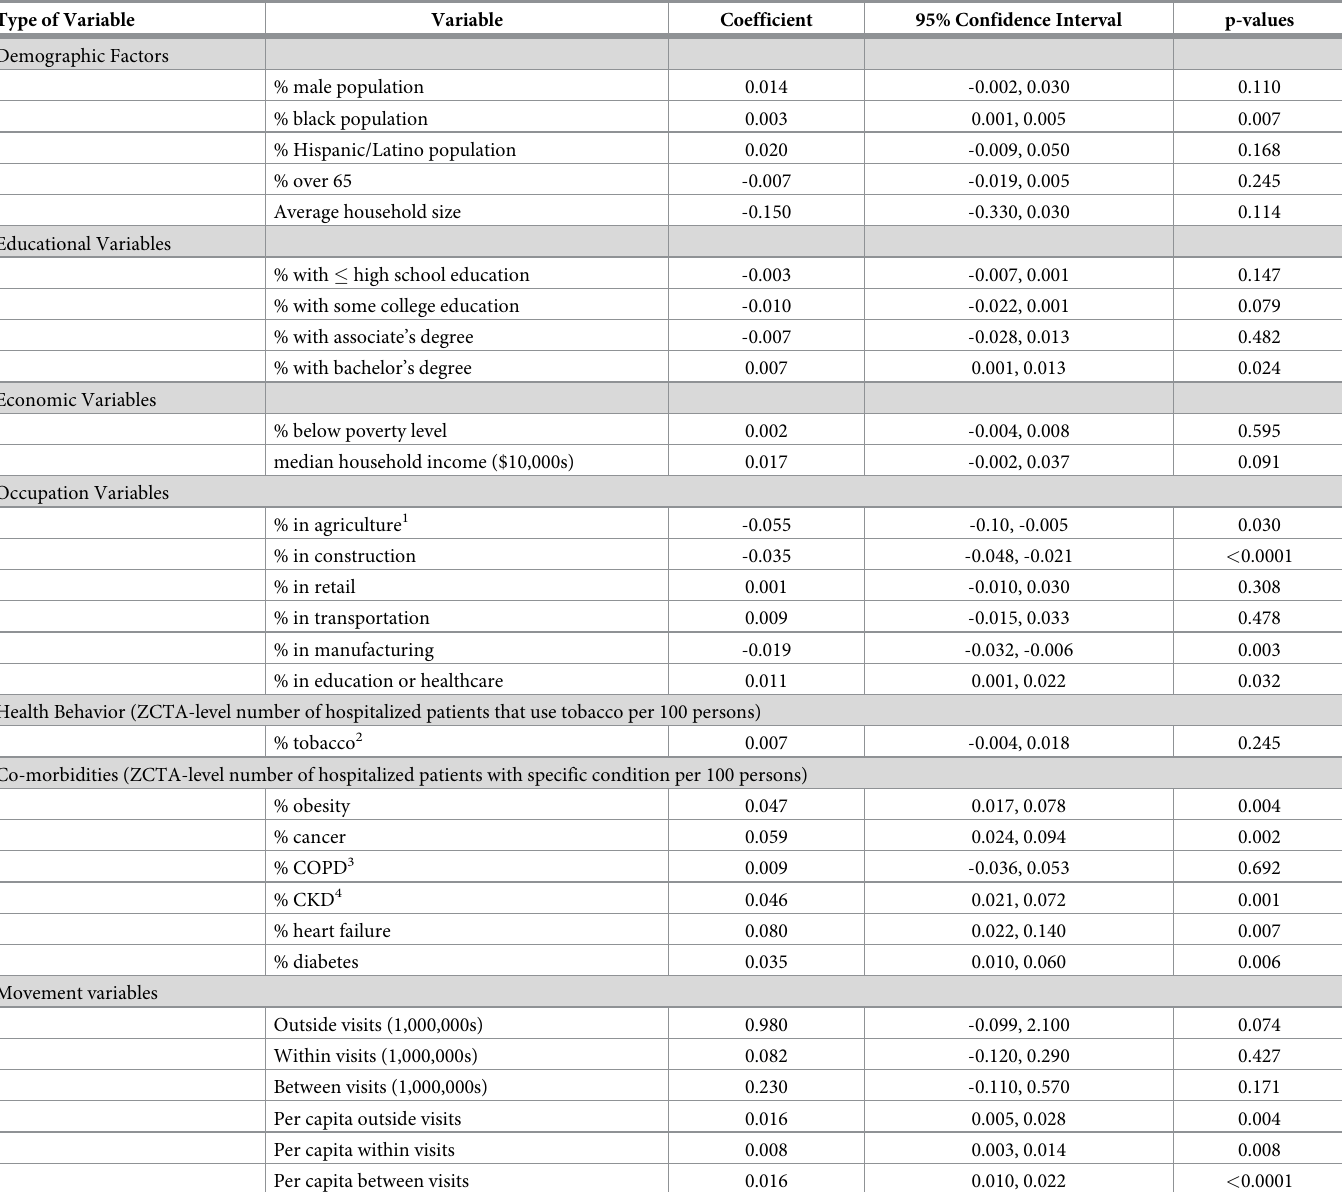
Table 2. Univariable associations between ZCTA-level COVID-19 risk and potential predictors in the Greater St. Louis Area, Missouri